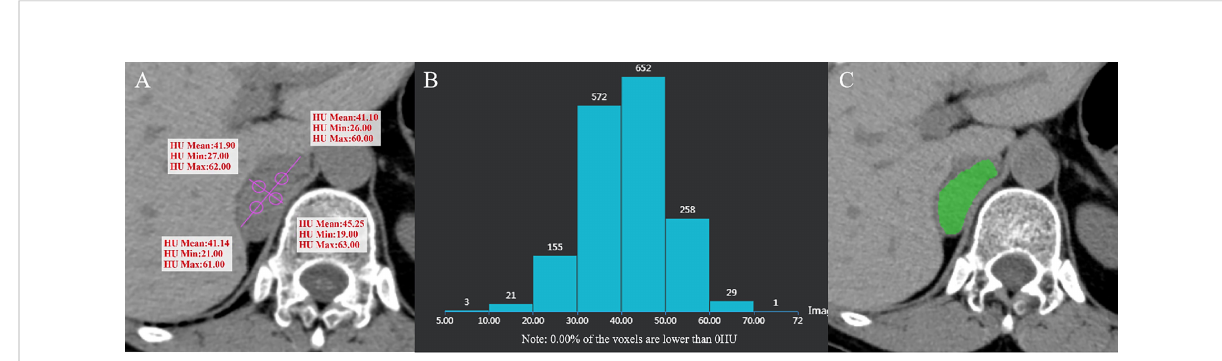
FIGURE 5 Pheochromocytoma of the right adrenal gland in a 64-year-old woman. AV mean = 41.345 HU, AV min = 23.25 HU (A) , and CTH negative pixel = 0 (B) . CT value in the green area is > 10 HU (C) .